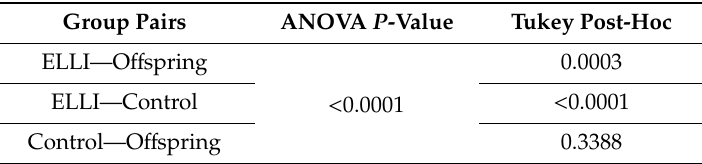
Table A6. One-way analysis of DNAmTL measurements.